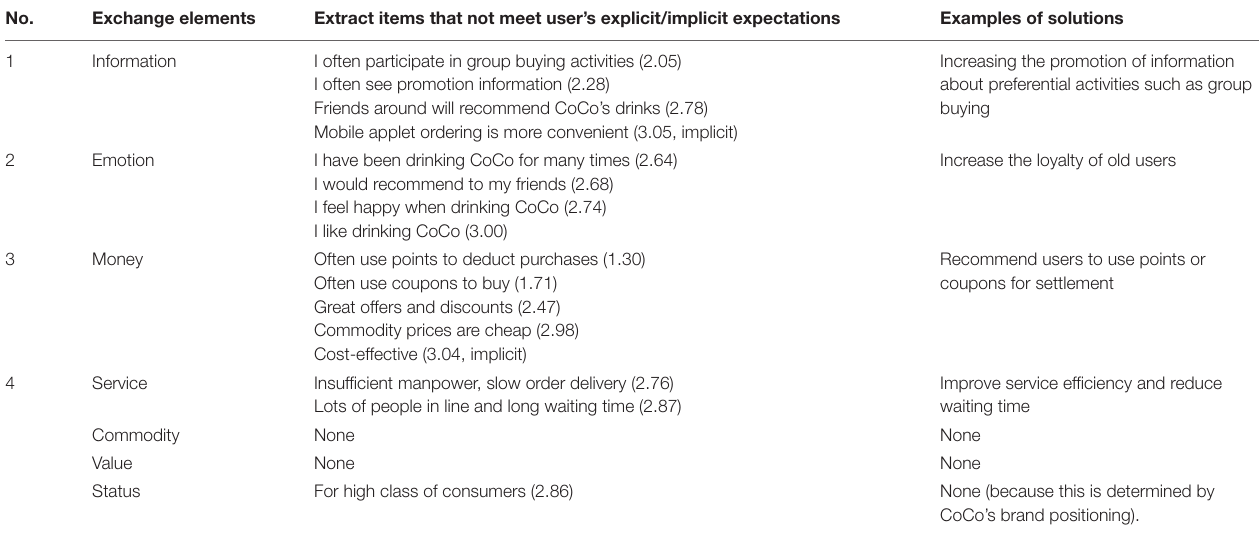
TABLE 4 | The results for extracted expectation. No.